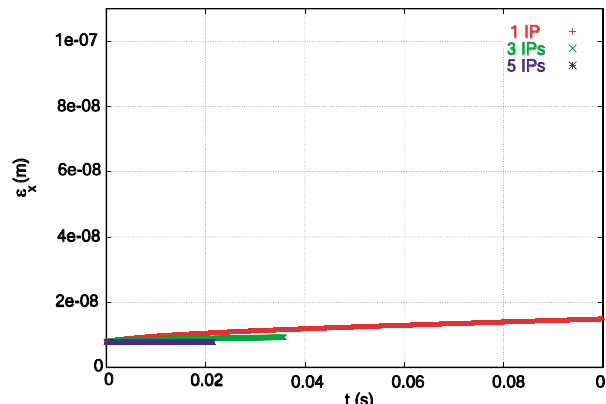
FIG. 78. (Color) Simulated evolution of LHC emittance versus (cid:3) 6 (cid:1) 10 11 m (cid:2) 3 in a full simulation with time in seconds for (cid:31) e fixed phase advances between IPs; the curves correspond to different numbers of electron-beam IPs [88].